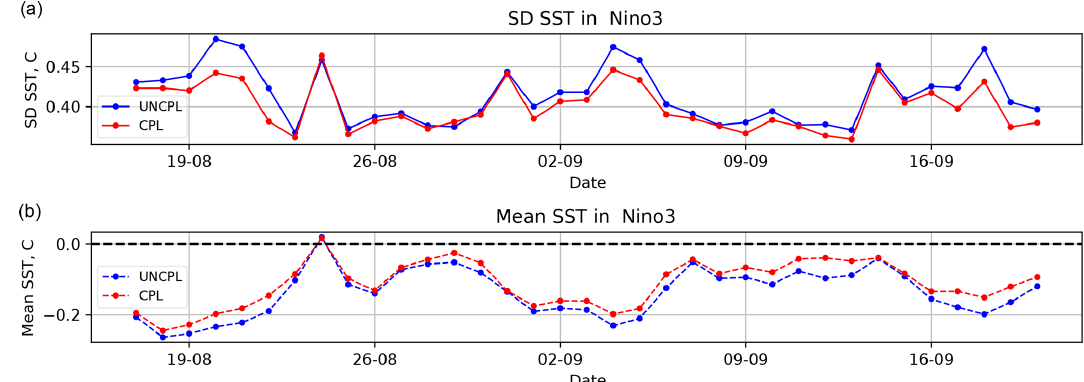
Figure 11. OmF standard deviation (a) and mean (b) with respect to the gridded foundation SST field from the ocean SAM2 DA component for the Niño3 region situated within the latitude–longitude box defined by [150, 90 ◦ W] and [5 ◦ S, 5 ◦ N]. The statistics are computed using 24h